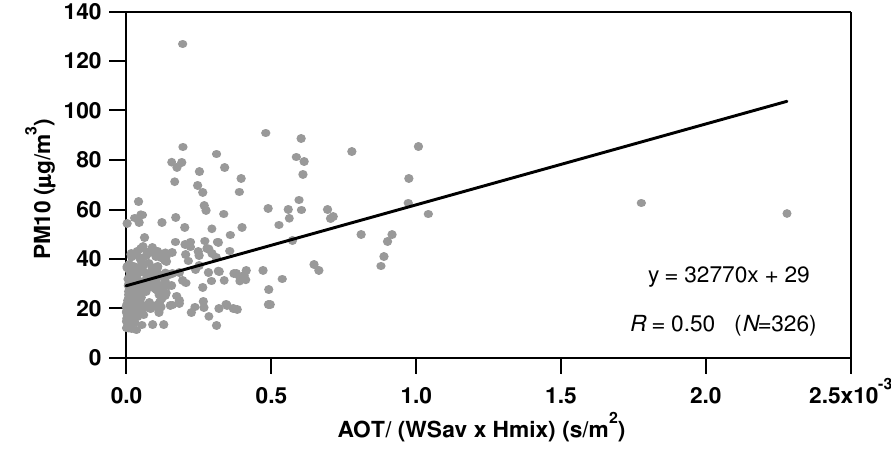
Figure 16. Scatterplot of PM10 versus AOT/(WSav × Hmix) by including the Arnesano and Guagnano data points referring to different years. The solid line represents the linear regression line fitting the data points. Slope, intercept, correlation coefficient ( R ), and total number of data points ( N ) are also given.